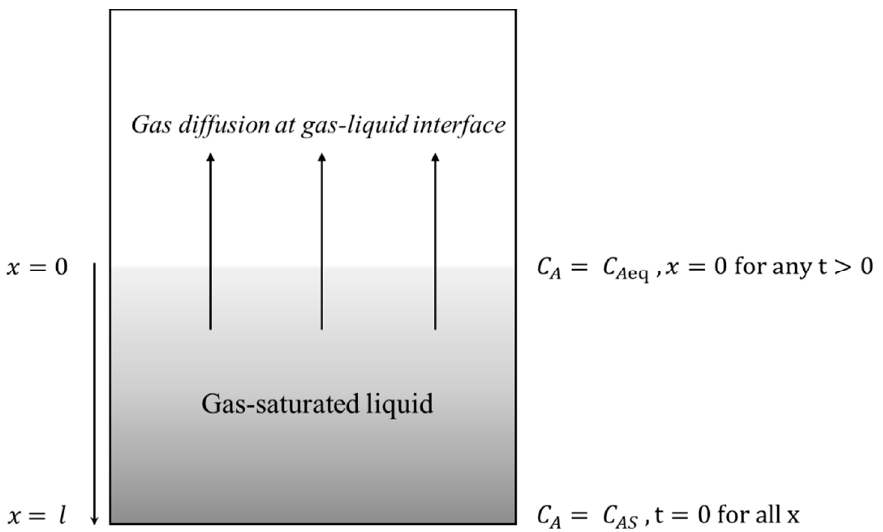
Figure 1. Schematic of bubble nucleation system used to study gas diffusion and saturation in a liquid.